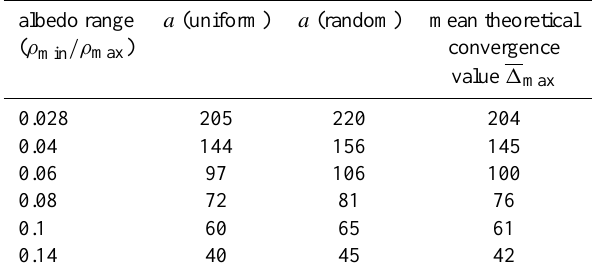
Table 1. Fit results of Eq.